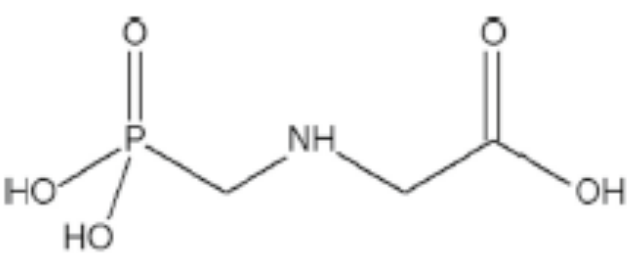
Figure 1. Glyphosate chemical structure. The covalent bond between the carbon and the phosphorus atoms is characteristic